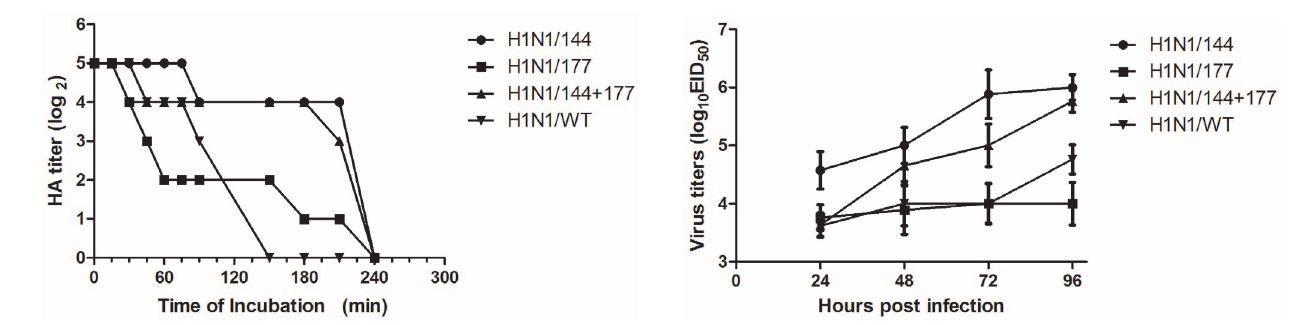
Virus HAI (NT) titers with monoclonal antibodies 1